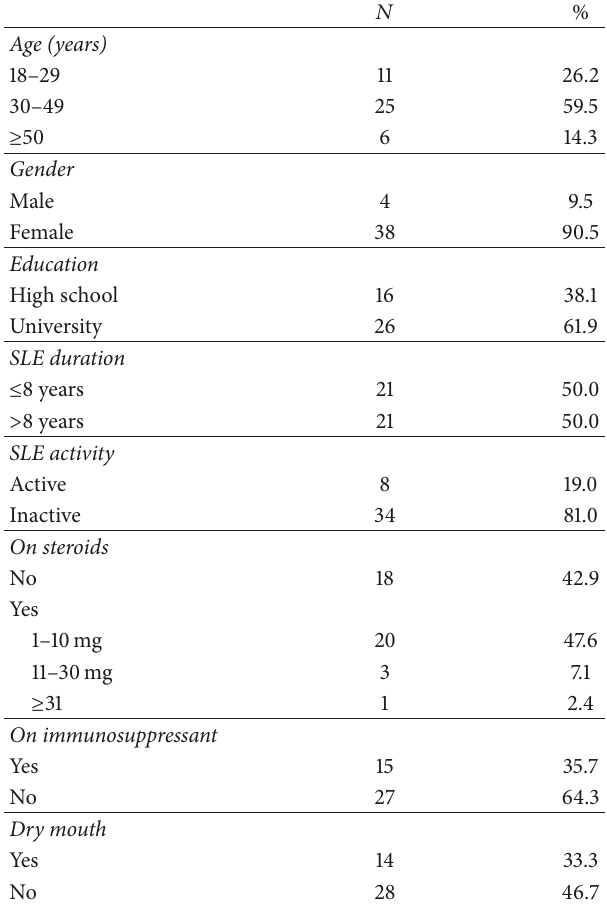
Table 1: Demographic and medical data of the study sample. Table 2: A summary of oral manifestations of the study